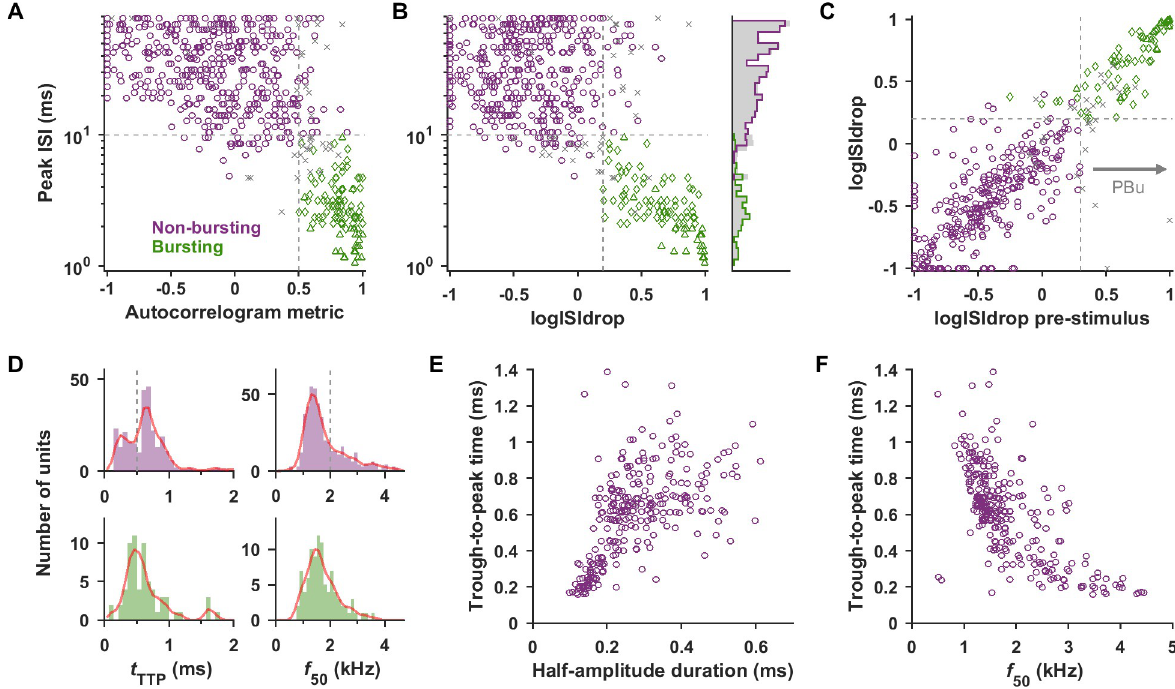
Fig 2. Bursting units could be separated from nonbursting units, and nonbursting units could be divided into RS- and FS-like populations. (A) Scatter plot of the peak ISI versus the autocorrelogram metric (a proxy for relative amount of short time scale autocorrelation). Color indicates label assigned by consensus criteria-based classification (boundaries shown in gray dashed lines, ambiguous unclassified units as gray x’s). The Bu1 and Bu2 subtypes of bursters (described in a later section) are distinguished as triangles and diamonds, respectively. (B) Scatter plot of peak ISI versus the logISIdrop metric. Marginal histograms are shown on the right for each labeled population (colored lines) and for the entire population including unclassified units (shaded gray bars). (C) Bursting occurs during spontaneous activity as well as the stimulus-driven period (see also S1 Fig). Comparison of logISIdrop calculated from the entire recording versus from the prestimulus period alone showed the 2 were strongly related. The group of units labeled as bursting based solely on having prestimulus logISIdrop > 0.3 are referred to as “PBu.” (D) Histograms and kernel density estimates (red lines) of t TTP and f 50 values for nonbursting units (purple) and bursting units (green). t TTP for nonbursting units shows bimodality with groups above and below approximately 0.5 ms (Hartigans’ dip test p < 0.001), presumably corresponding to RS and FS units. t TTP for bursting units is intermediate and peaks around 0.5 ms. f 50 for nonbursting units is also suggestive of bimodality with 2 overlapping groups— one centered around 1.5 kHz (RS) and one extending out above 2 kHz (FS), but Hartigans’ dip test did not reach significance. Boundaries for criteria-based classification of nonbursting units into RS and FS are shown (gray dashed lines). (E) Scatter plot of nonbursting unit t TTP versus half- amplitude spike duration shows a broad cluster above t TTP = 0.5 ms and an elongated group below. The distribution is similar to that seen in Bartho´ and colleagues [34], where inhibitory/excitatory status was confirmed by crosscorrelogram analysis. Eight outliers with t TTP > 1.6 are beyond the axes of the plot. A random jitter of up to half the minimum resolution was added to offset points with the same coordinates. (F) Scatter plot of t TTP versus f . Units with t TTP below approximately 0.5 ms generally had f above 2 kHz. Data underlying this figure can be found in S1 Data. FS, fast- 50 50 spiking; ISI, interspike interval; RS,